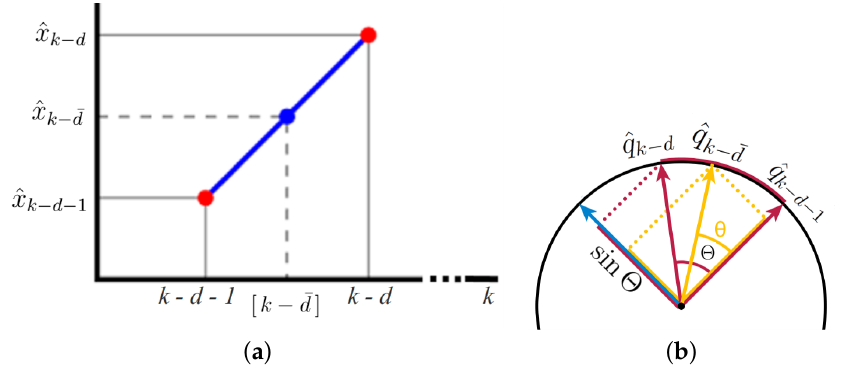
Figure 3. Examples of interpolation and slerp. ( a ) Linear interpolation, ( b ) Quaternion